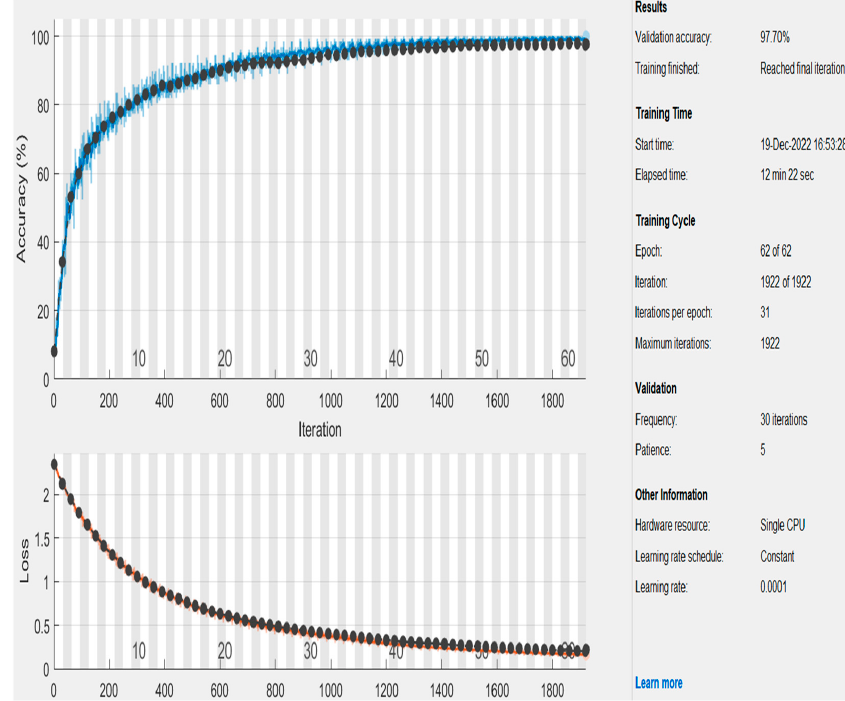
Figure 5. The achieved results of accuracy and the loss function using L a .